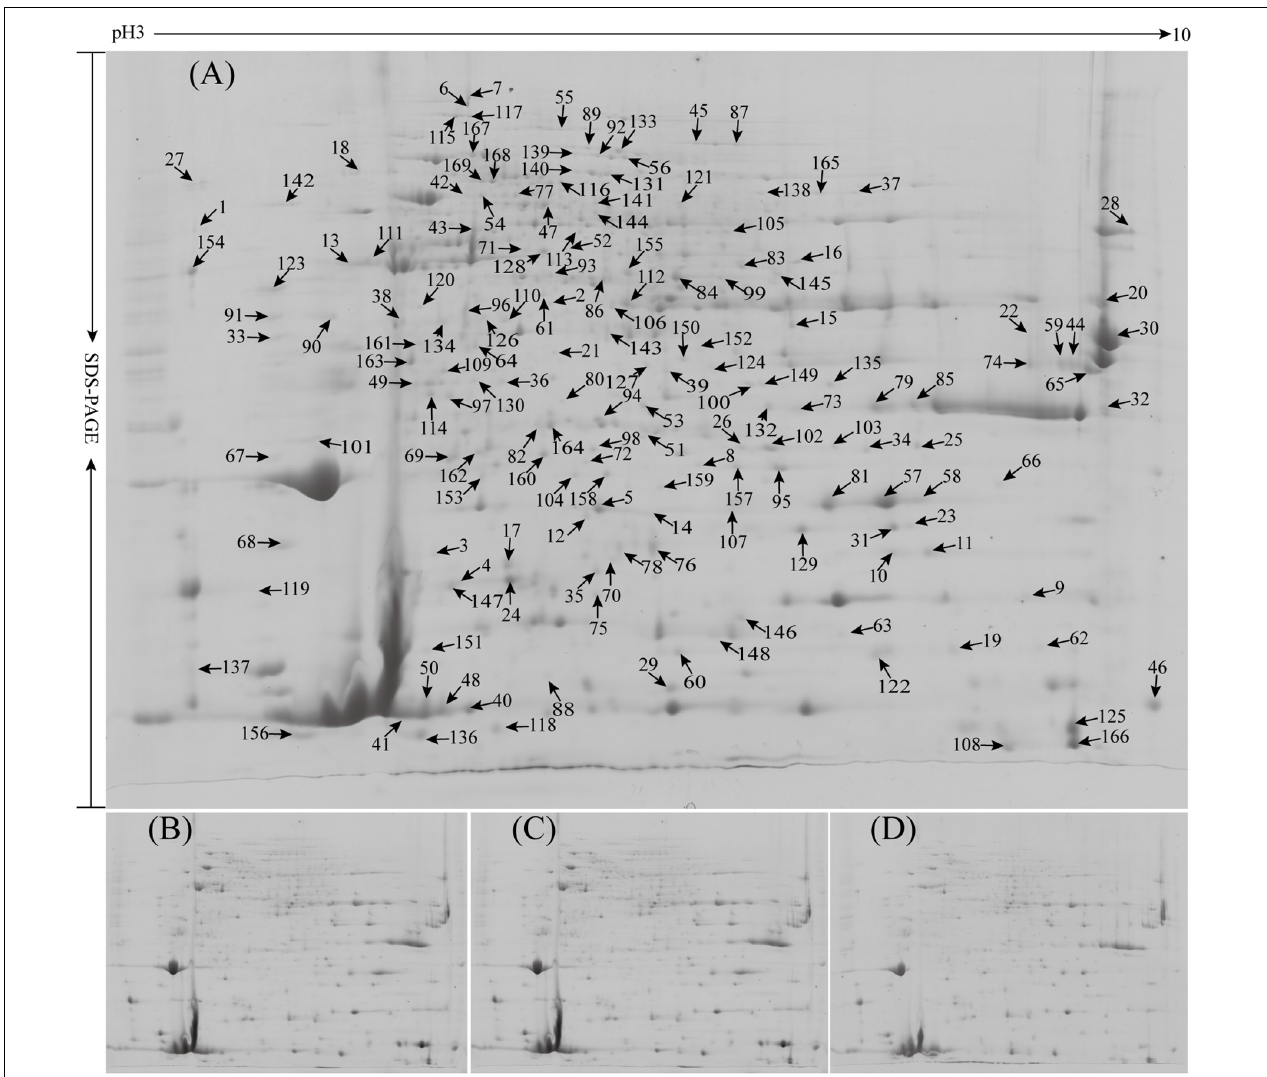
FIGURE 2 | Proteome profiles of rubber latex under different treatments. Total latex proteins from rubber trees treated with the control (CK, A ), 0.5% ethylene (Eth, B ), 1.5% ammonium molybdate (Mo, C ), and 0.5% Eth combined with 1.5% ammonium molybdate (EMo, D ) were separated by 2-DE, and the positively identified DEPs in the 2-DE gels were marked with numbers (from spot 1 to 169). The protein identities are listed in Supplementary Figure S2 and Supplementary Table S1